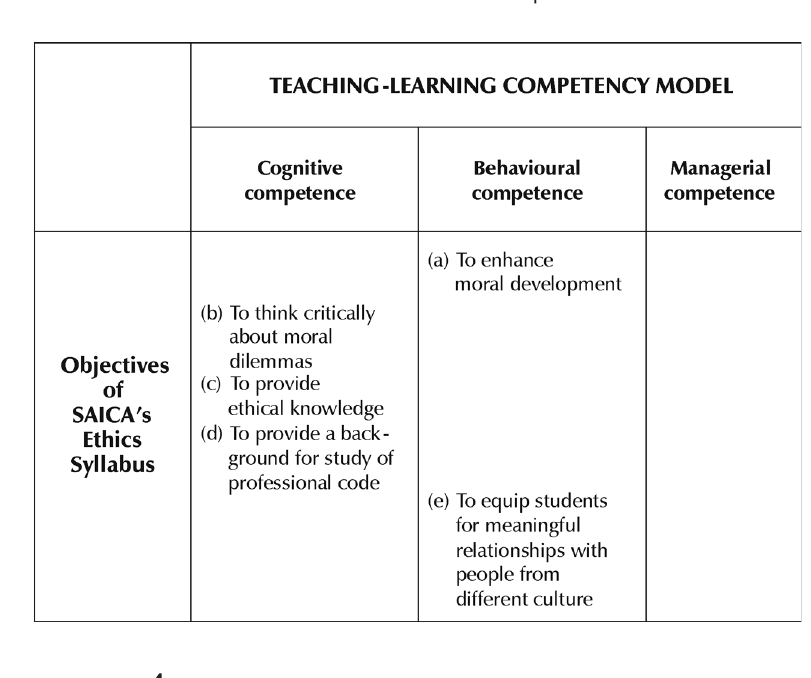
SAICA and TLC framework